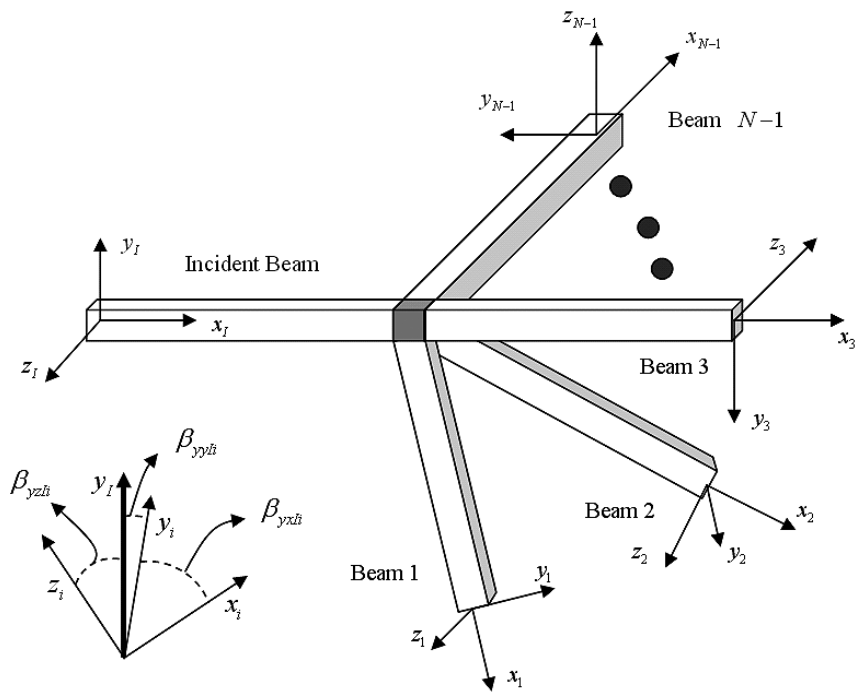
Fig. 1. N semi-infinite undamped Timoshenko beams coupled in three-dimensional joint and the indication of angles among coordinates